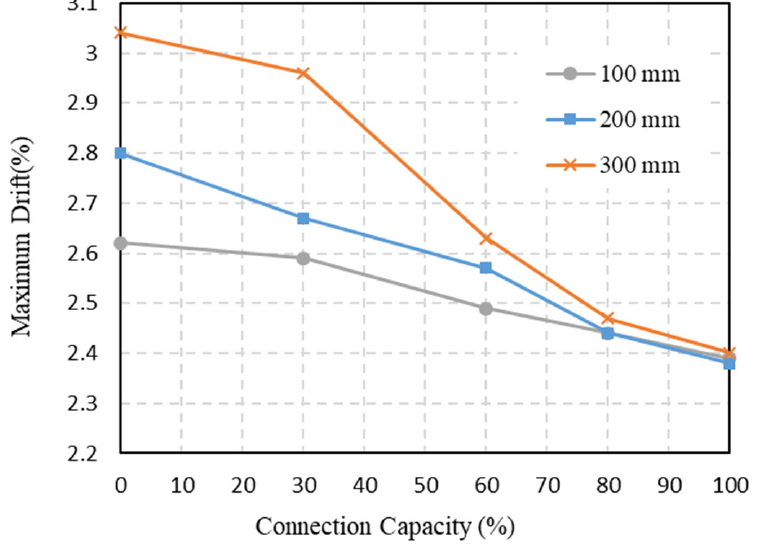
Figure 20. Maximum story drifts of 10-story frame subjected to 5 earthquake records.